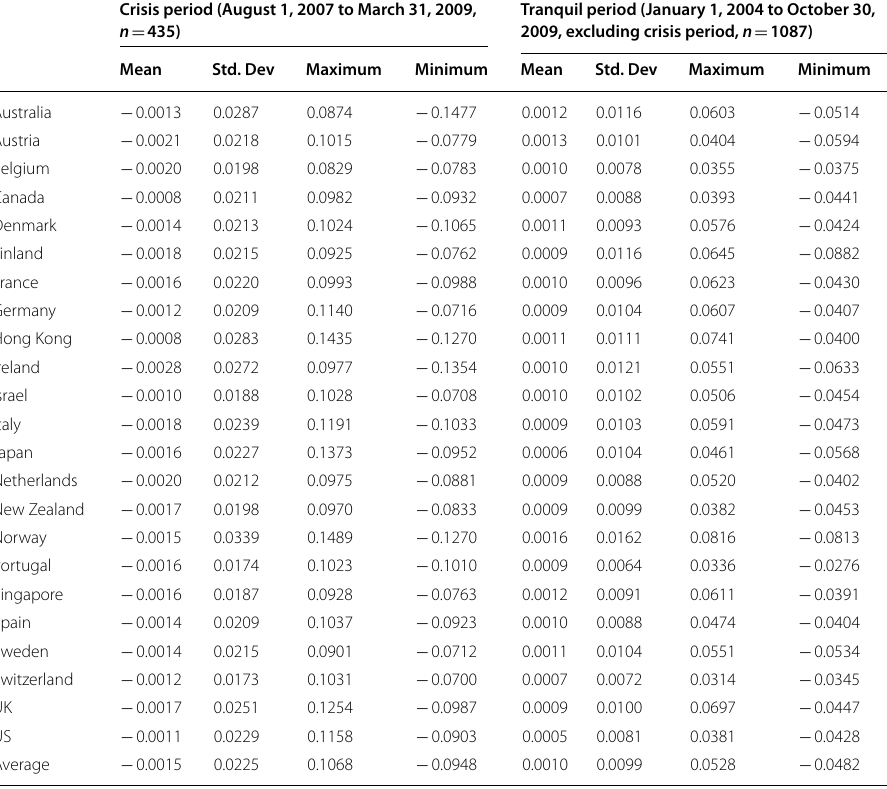
This table shows the summary statistics of the aggregate stock market indices’ daily returns for the developed markets during the crisis and tranquil periods. The crisis period spans August 1, 2007 to March 31, 2009, and the tranquil period spans January 1, 2004 to October 31, 2009, excluding the crisis